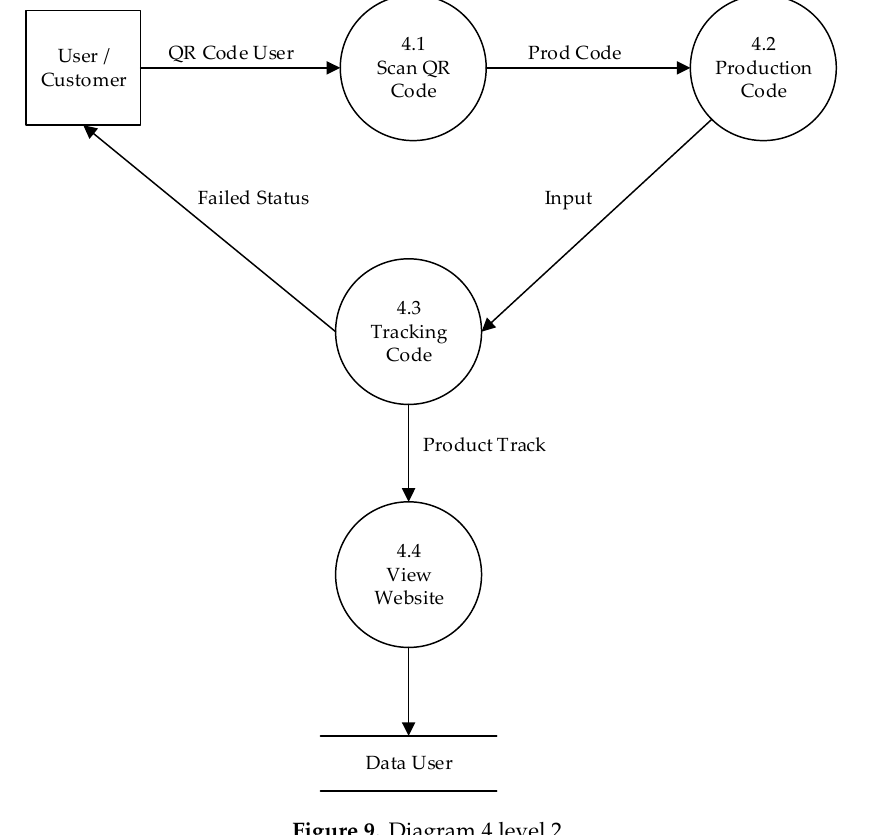
Figure 8. Diagram 3 level 2.